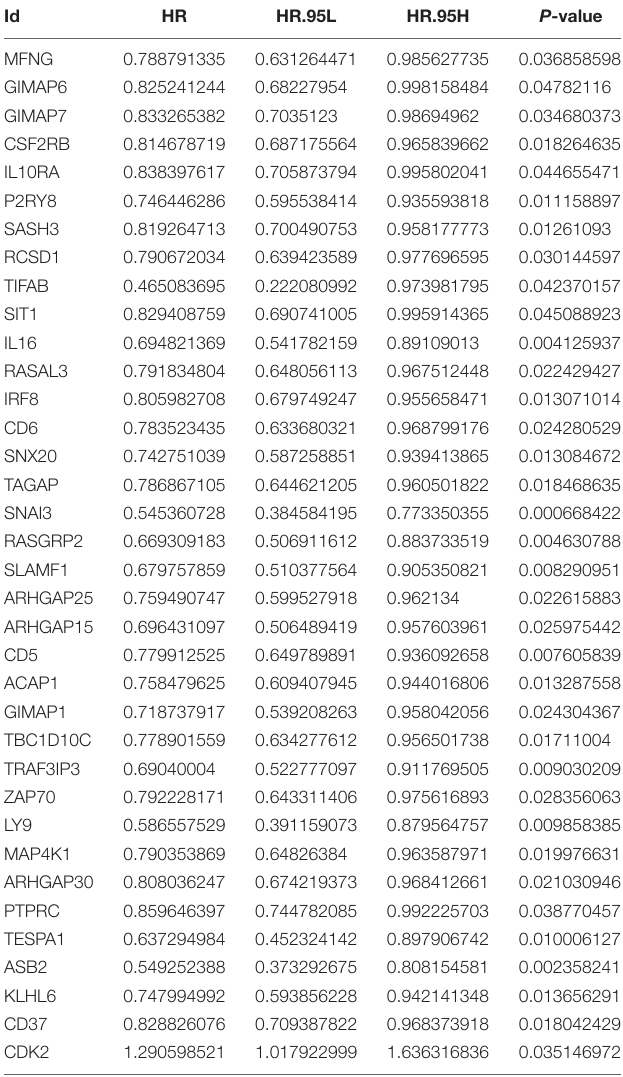
TABLE 5 | The analysis of Univariate regression about 36 genes.